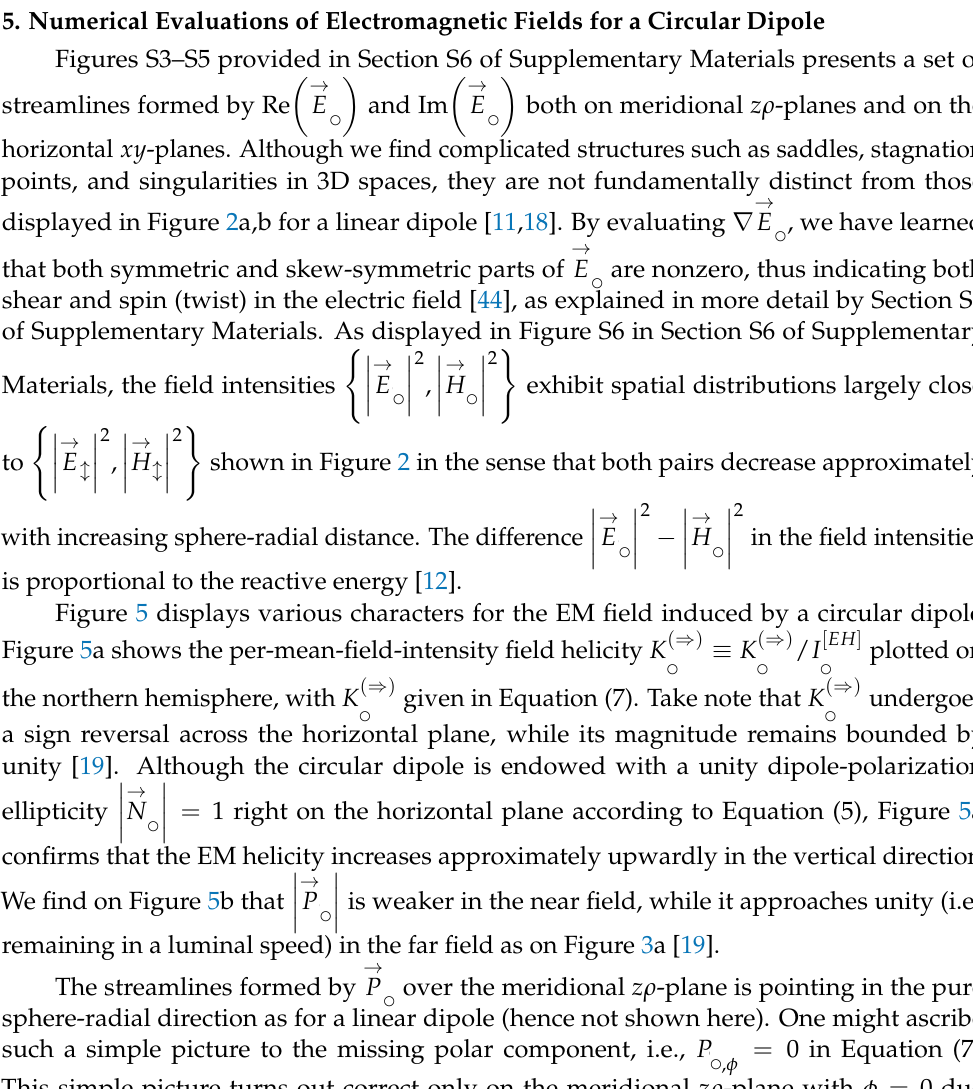
  Figure 1. ( a ) Decomposition of a Poynting vector P into an orbital energy flux O and a spin   energy flux S . Besides, M is a spin angular momentum (SAM) density. ( b ) The coordinate systems. On the origin lies a primary electric point dipole represented by its unit vector ˆ p . ( c ) A linear dipole ˆ p with its dipole axis lying parallel to the vertical axis leads to a pencil-hull-like  tapered cylindrical surface designating higher values for the degree of circular polarization